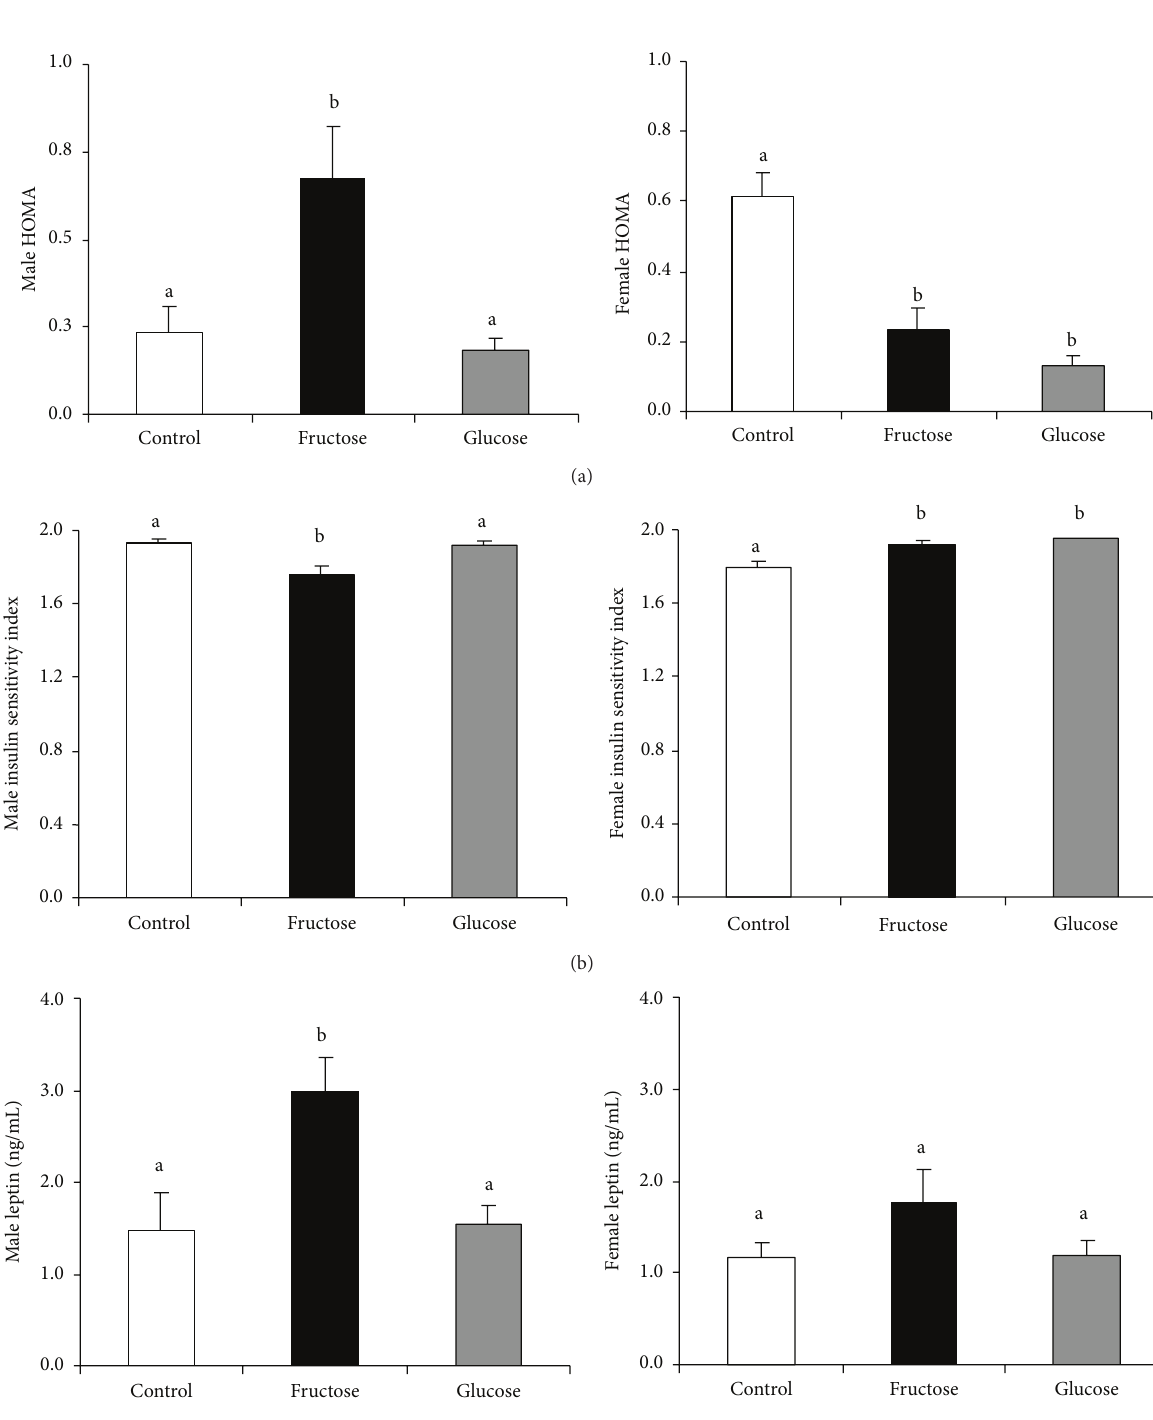
Figure 1: Fructose in pregnancy produces insulin resistance and hyperleptinemia in progeny. Male and female (a) HOMA-IR and (b) ISI ratios and (c) leptinemia of 24-hour fasted 90-day-old progeny from control, fructose-fed, and glucose-fed pregnant rats. Data are means ± SE; 𝑛 = 10 –12 animals from four litters. Different letters indicate significant differences between the groups ( 𝑃 < 0.05